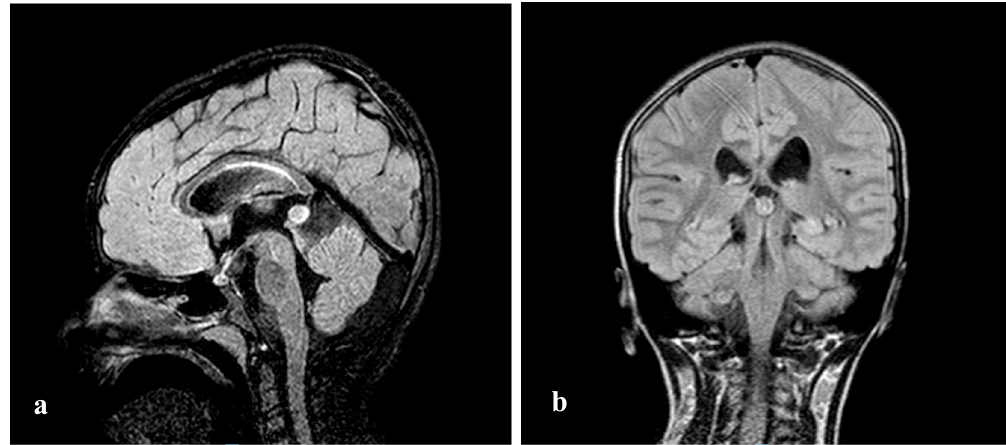
a b a b Figure 2. Poly-lobed cystic pineal gland in sagittal ( 2a ) and coronal ( 2b ) T2 FLAIR sections. Figure 2. Poly-lobed cystic pineal gland in sagittal ( 2a ) and coronal ( 2b ) T2 FLAIR sections. Figure 2. Poly-lobed cystic pineal gland in sagittal ( 2a ) and coronal ( 2b ) T2 FLAIR sections. Figure 2. Poly-lobed cystic pineal gland in sagittal ( a ) and coronal ( b ) T2 FLAIR sections.